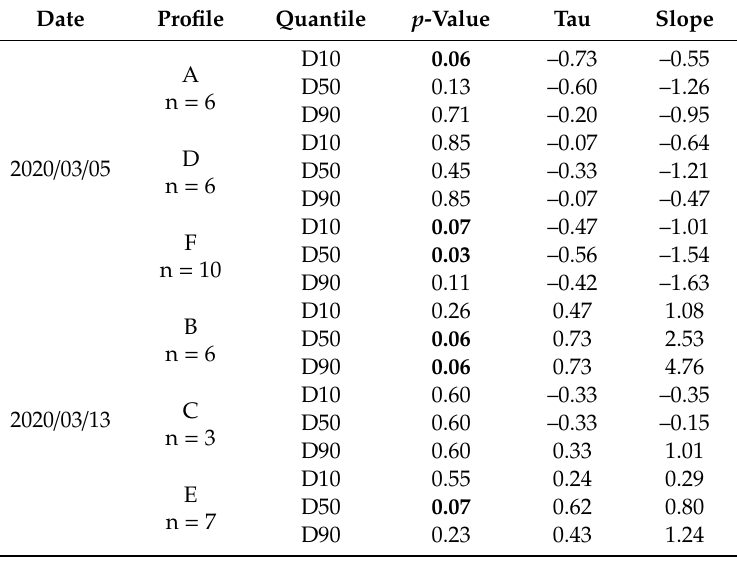
Table 1. Mann–Kendall statistical test applied to the pebble size profiles measured in Etretat on 5 March and 13 March, 2020, p -Values in bold are inferior to the 0.1 significance